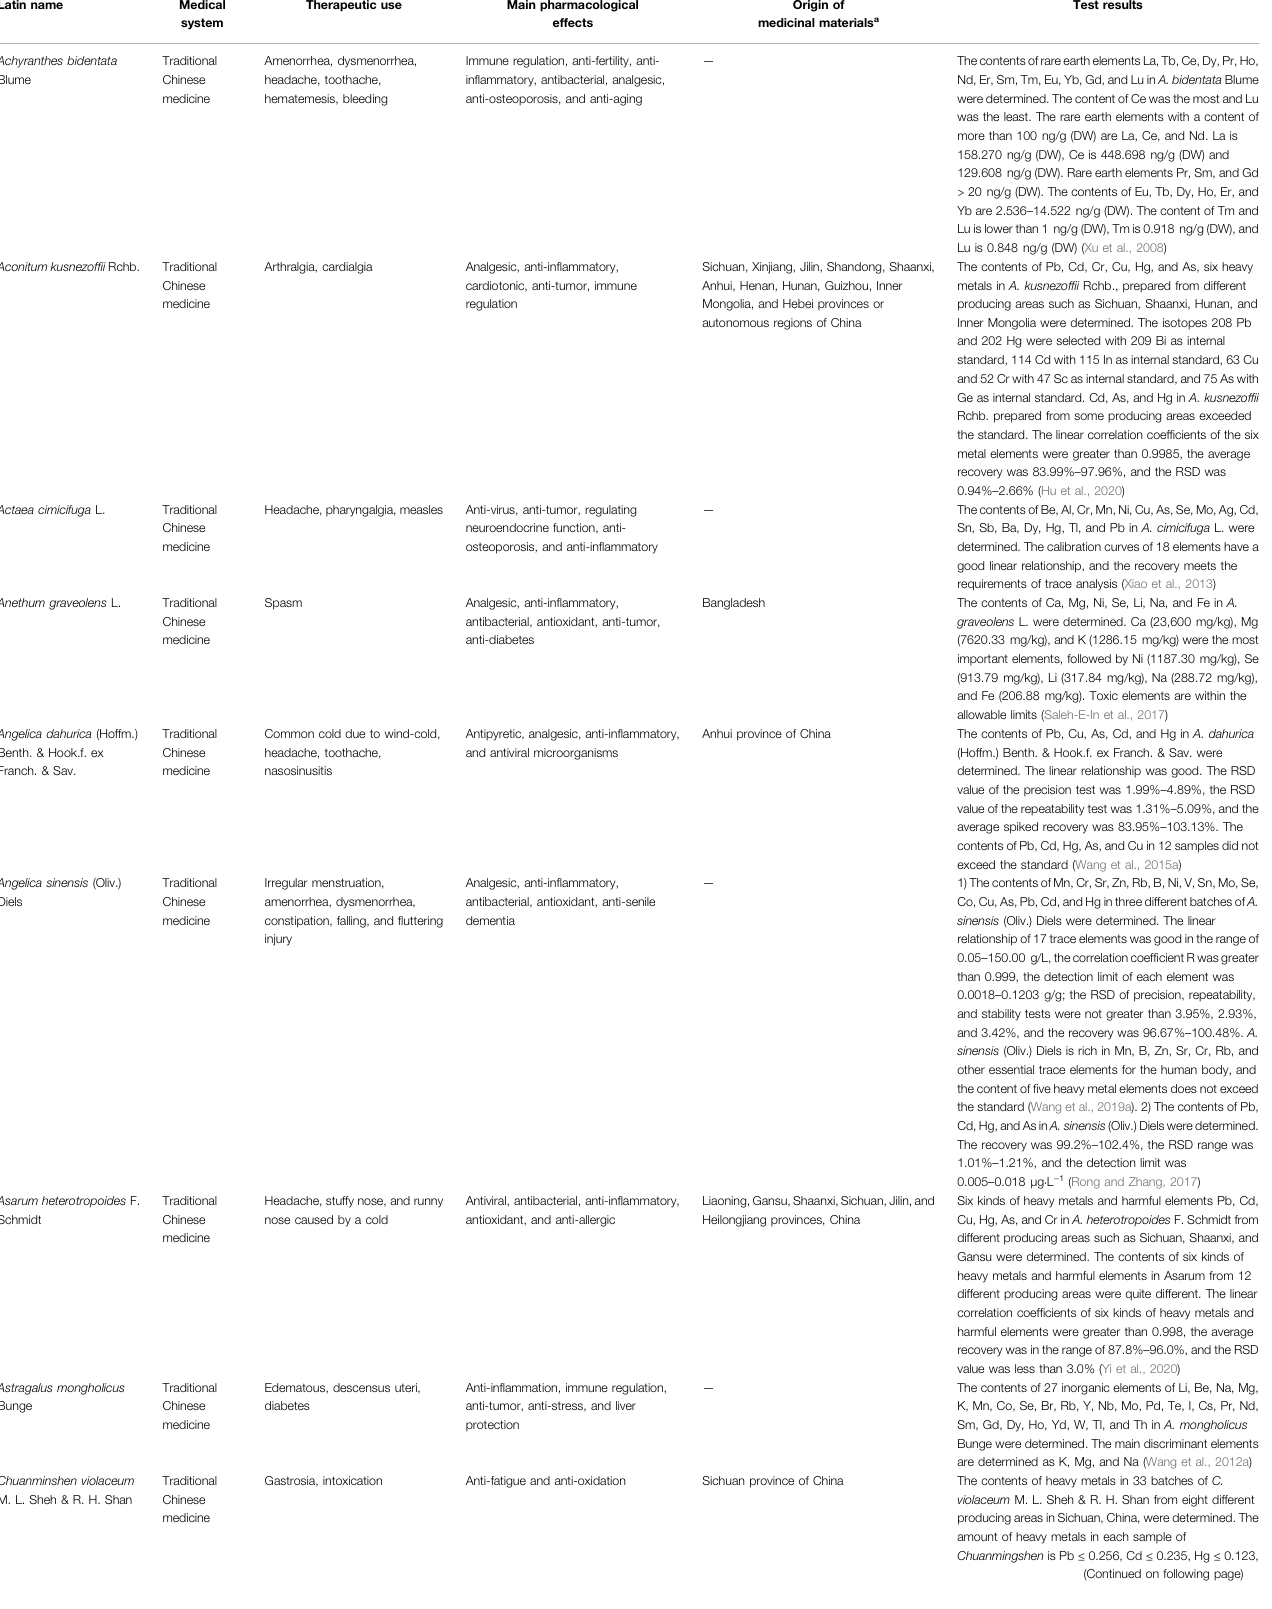
TABLE 1 | Application of ICP-MS in the determination of heavy metal elements in medicinal materials derived from the roots of